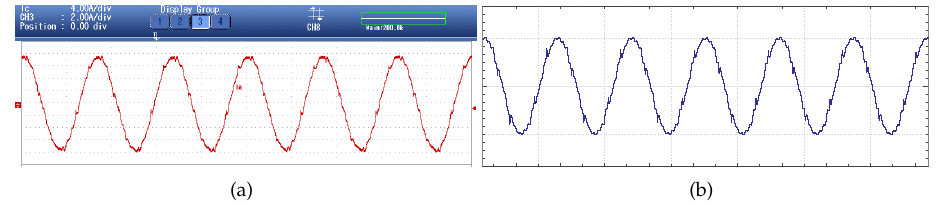
Figure 24. Grid current waveform for Case 1, THD = 4.2%: ( a ) measured current; ( b ) simulated